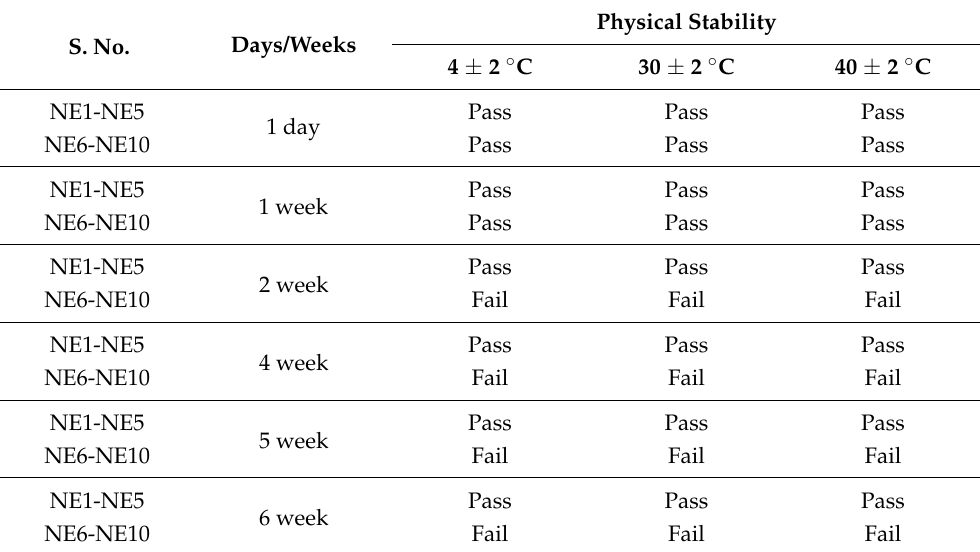
Table 2. Physical stability testing of the selected nanoemulsion at the S mix ratio of 3:1. S. No.